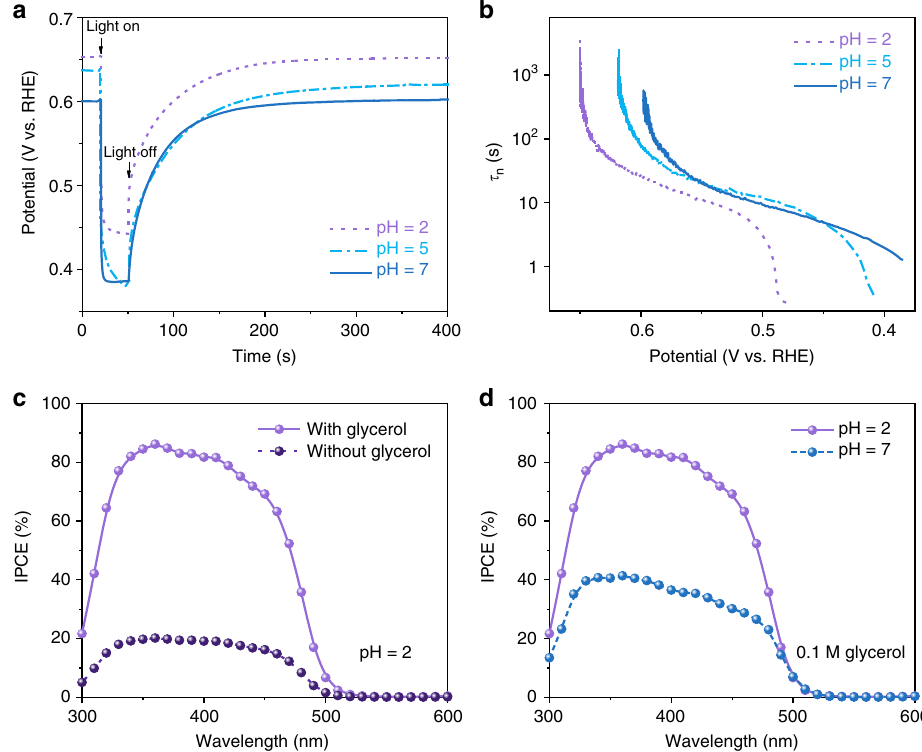
Fig. 3 Charge carrier dynamics. a , b Transient OCVD pro fi les and lifetimes of photogenerated charge carriers of porous BiVO 4 nanoarray photoanode in 0.5 M Na 2 SO 4 at various pH. c , d Incident photon-to-current conversion ef fi ciency spectra of porous BiVO 4 nanoarray